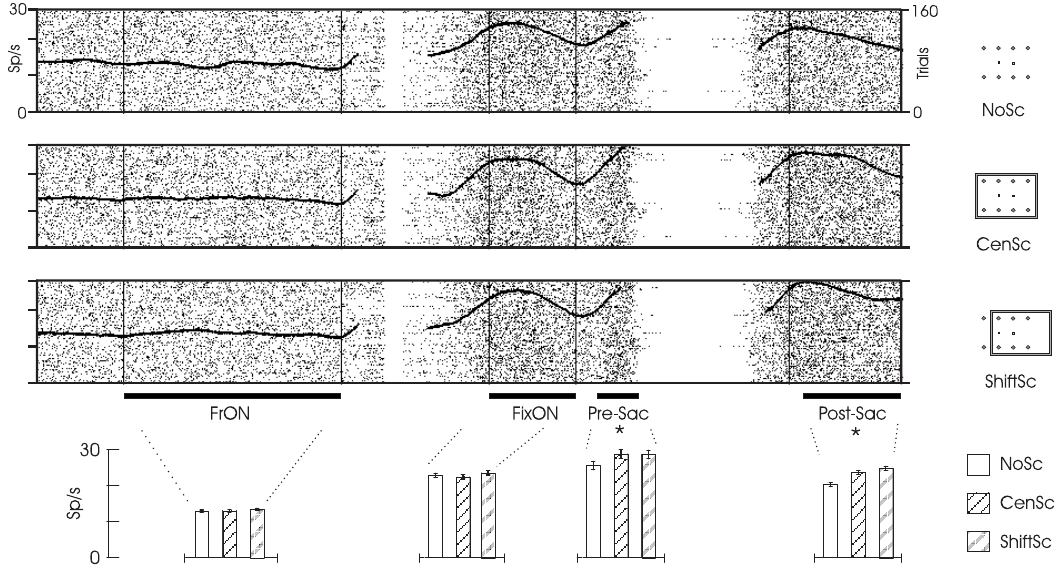
Fig. 3 – Example of a neuron with contextual scene modulation exclusively target-dependent. Conventions as in Fig. 2. Contrary to the unit illustrated in Fig. 2, this cell does not present differential modulation by the frame prior to the appearance of the target. The neurons firing rate only distinguished the presence of the scene after the target was turned on, as confirmed by one-way ANOVA analyzes between the scene contexts (Pre-Sac: P < 0 . 03 and Post-Sac: P < 10 − 7 ). See also legends for Figs. 1 and